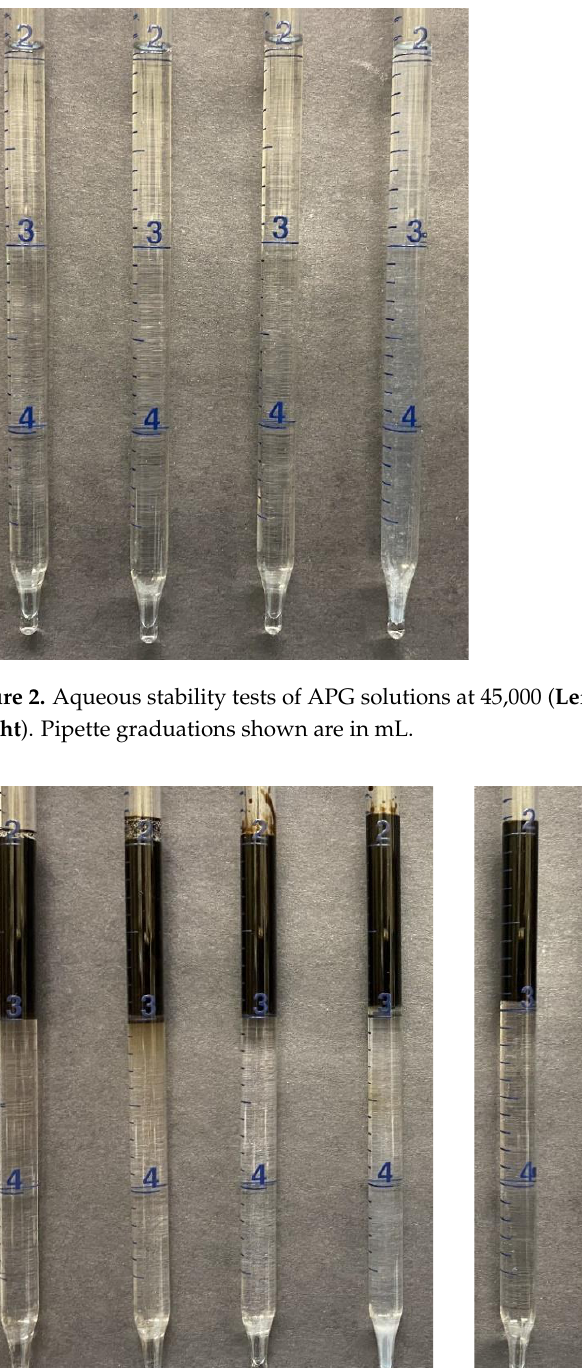
Figure 2. Aqueous stability tests of APG solutions at 45,000 (Left), 85,000, 144,000, and 180,000 ppm (Right). Pipette graduations shown are in mL.